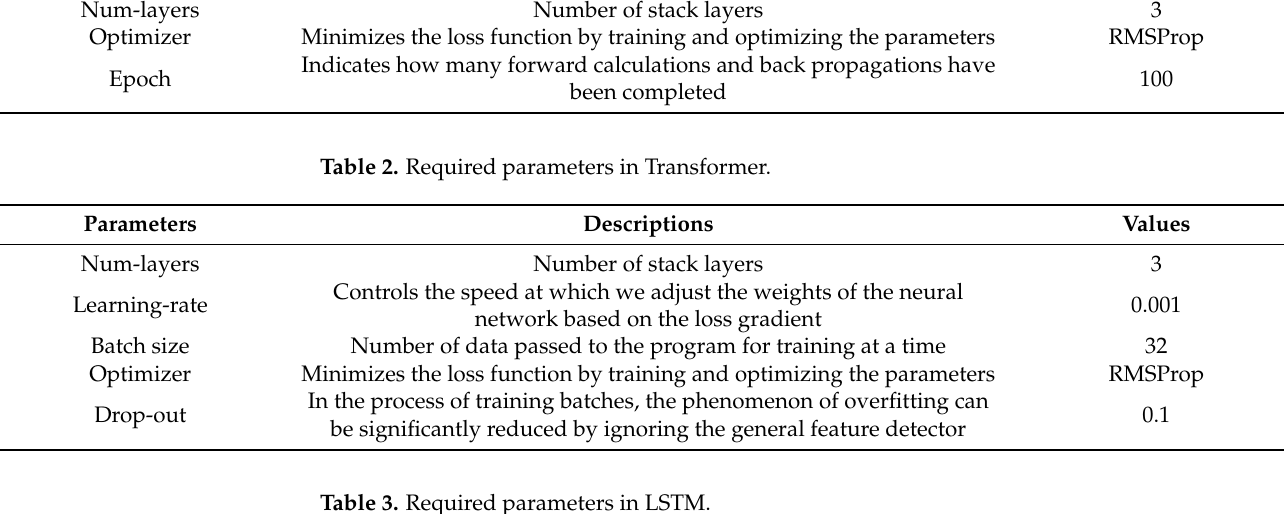
Table 3. Required parameters in LSTM.